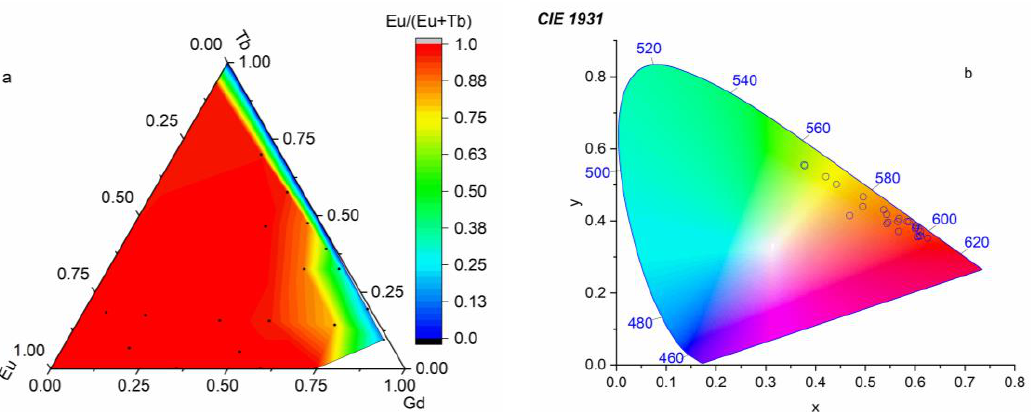
Figure 7. ( a ) Compositions of ternary layered Gd-Eu-Tb basic sulfobenzoates; the colour indicates the intensity ratio of europium I Eu (615 nm) and terbium I Tb (544 nm) bands µ = I Eu /( I Eu + I Tb ). ( b ) Luminescence colour coordinates of layered Gd-Eu-Tb basic sulfobenzoates.